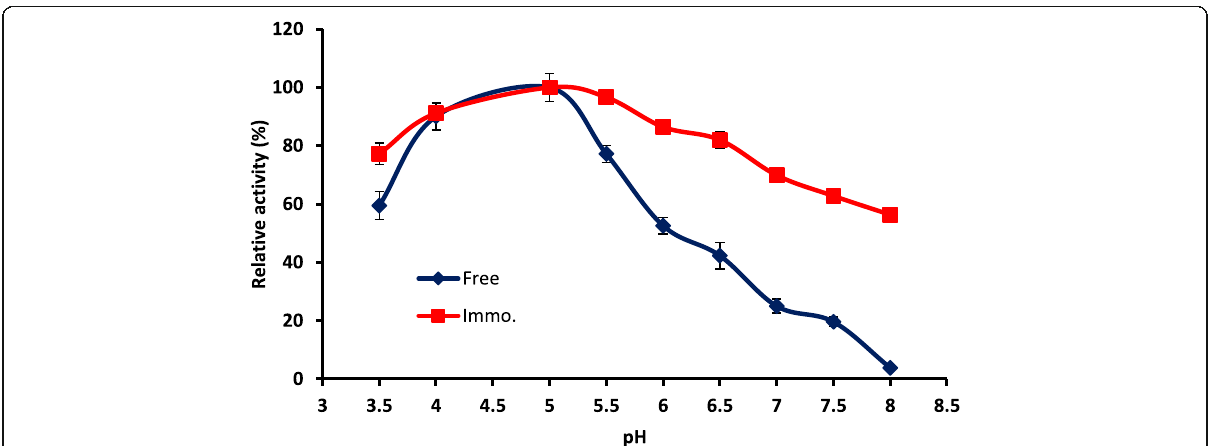
Fig. 7 Optimum pH for free and covalently immobilized glucoamylase enzyme onto activated gel